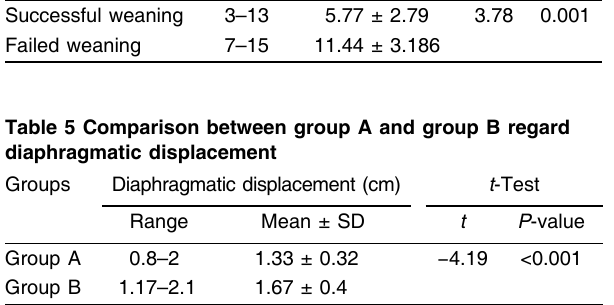
Successful weaning